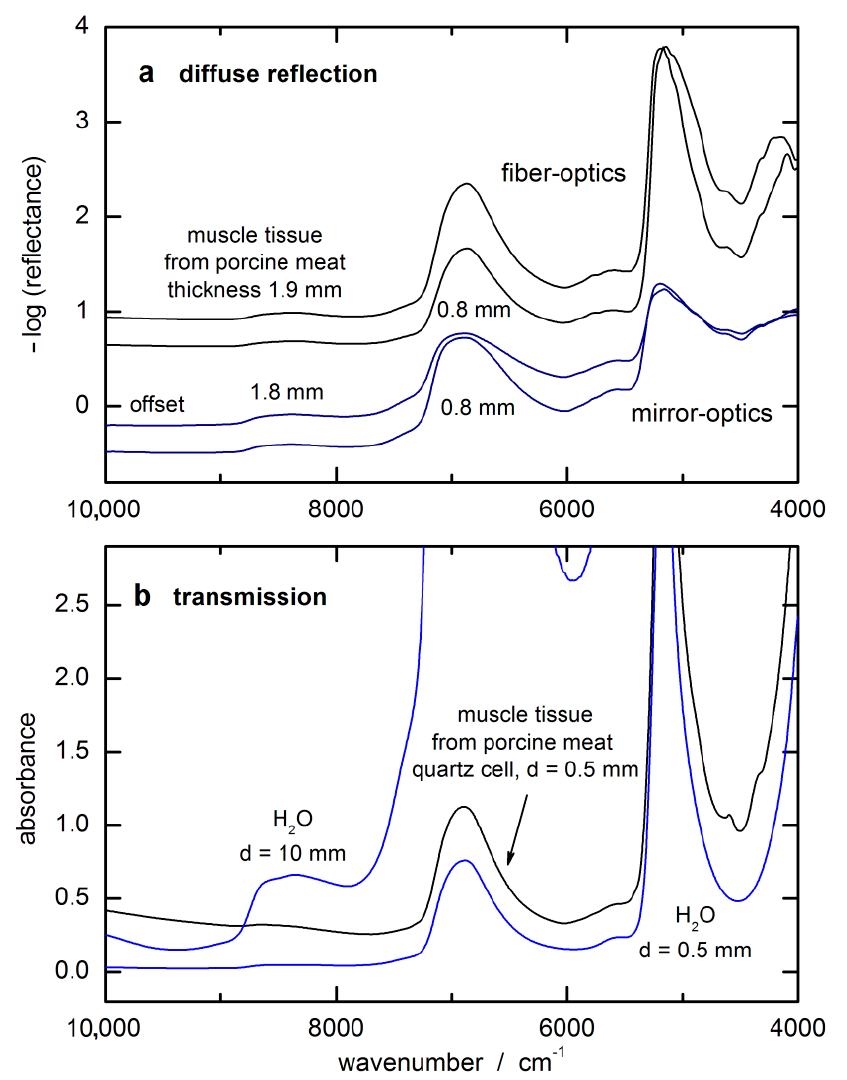
Figure 2. Spectra of tissue phantoms of constant layer thicknesses illustrating wavelength-dependent radiation penetration: ( a ) monitored with different accessories (for the first two spectra, a fiber-optic probe of type I was used); ( b ) transmission spectra of water and tissue. Before the lip measurements were started, the test person had to rinse their mouth with plain water. After patting the lip dry, the spectra were taken reproducibly by slightly pressing the inner lower lip (oral mucosa) against the half-spherical lens of the reflection accessory. The duration of the lip measurements was 1 min for averaging 1200 single-sided interferograms providing a spectral resolution of 32 cm − 1 after Fourier-transformation and phase correction. For examples of single-beam spectra of oral mucosa tissue and gray Spectralon standard with 5% reflectance, see also Figure 3a. The lip spectrum and noise level, obtained from two consecutive tissue measurements with baseline correction, is given in absorbance equivalent units in Figure 3b. The log-converted single-beam lip spectrum is also displayed, which shows differences only in a smooth and constant baseline compared to the –log (reflectance) spectrum. The hardware noise within the log-converted √ single-beam spectra is smaller by a factor of 2 than that found in the absorbance spectra as calculated from two noise-loaded single-beam